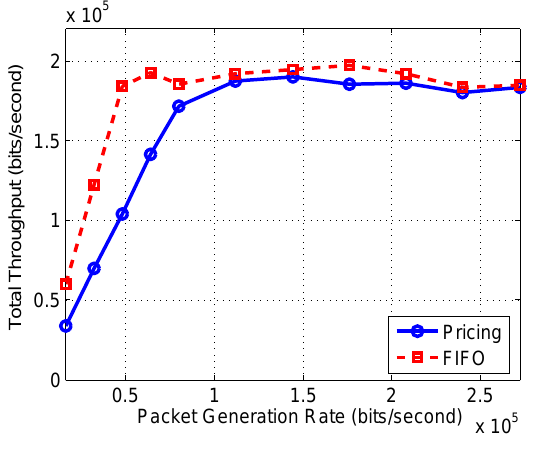
Figure 13. Aggregate system throughput for chain topology.